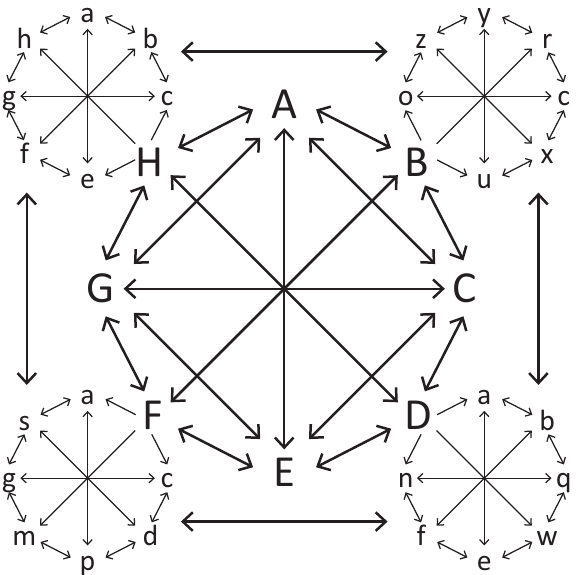
Figure 3. Polycentric network development (Starkey,